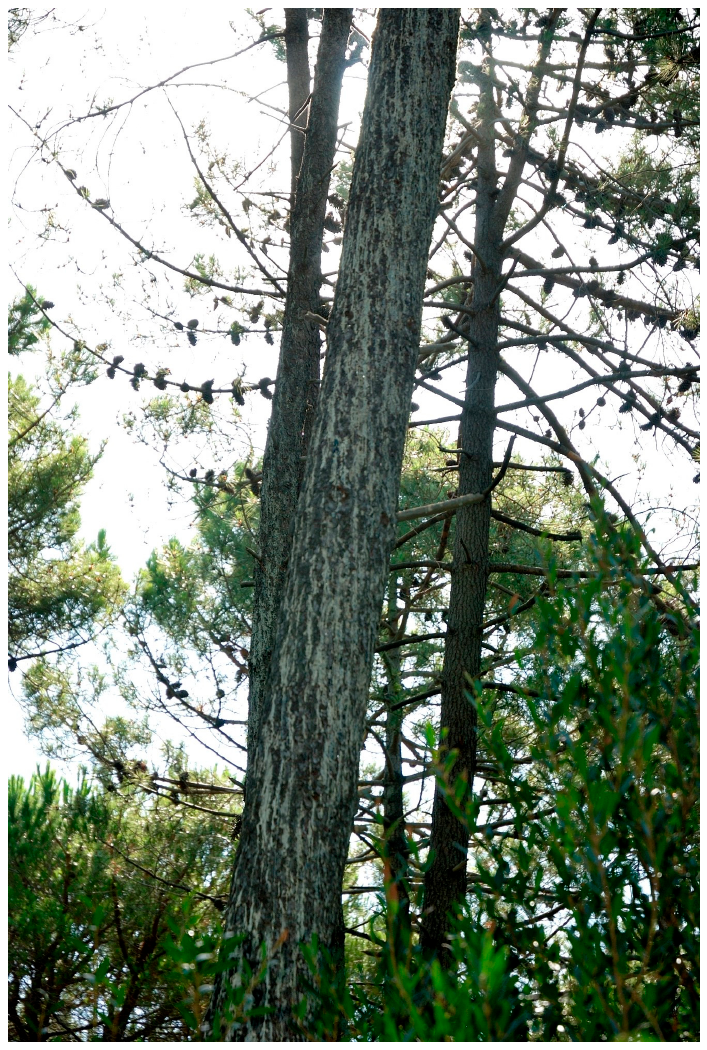
Figure 3. Copious exudation of resin on a maritime pine infested by Matsucoccus feytaudi